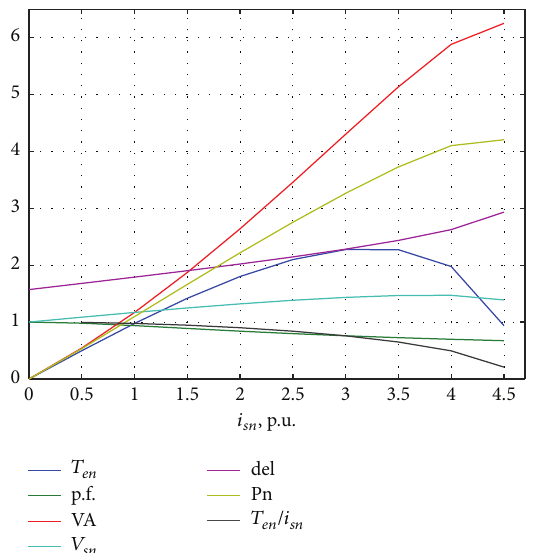
Figure 6: Performance characteristics of constant mutual air gap flux linkages control for SMPMSM.